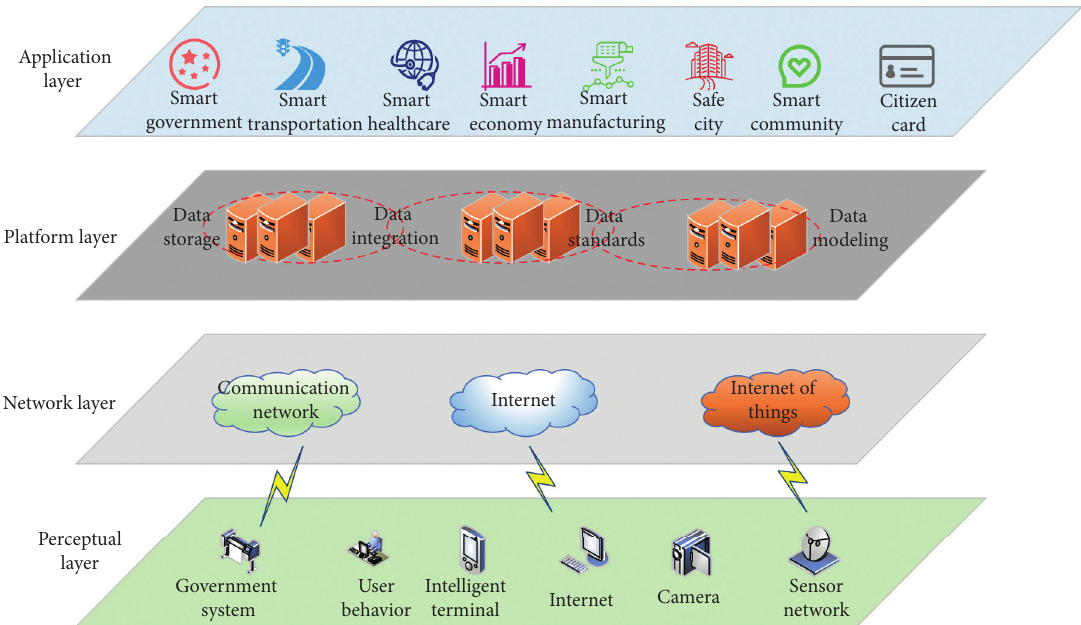
Figure 1: The system architecture of smart city.